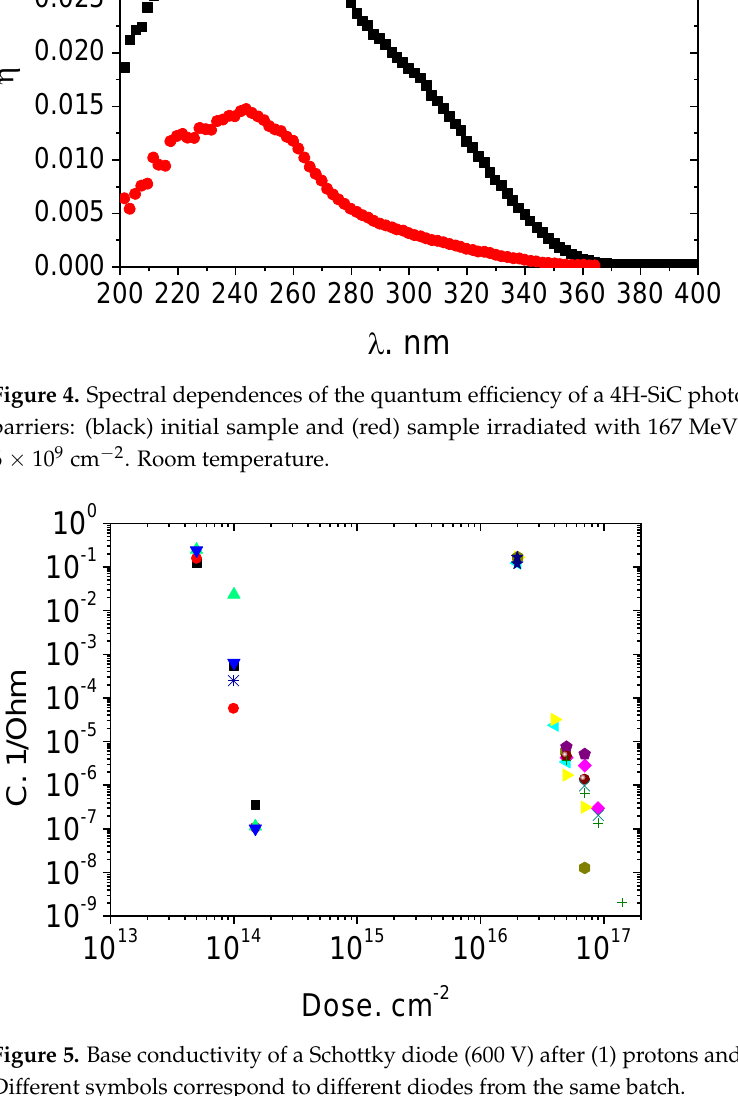
Figure 5. Base conductivity of a Schottky diode (600 V) after (1) electron and (2) proton irradiation. Different symbols correspond to different diodes from the same batch.